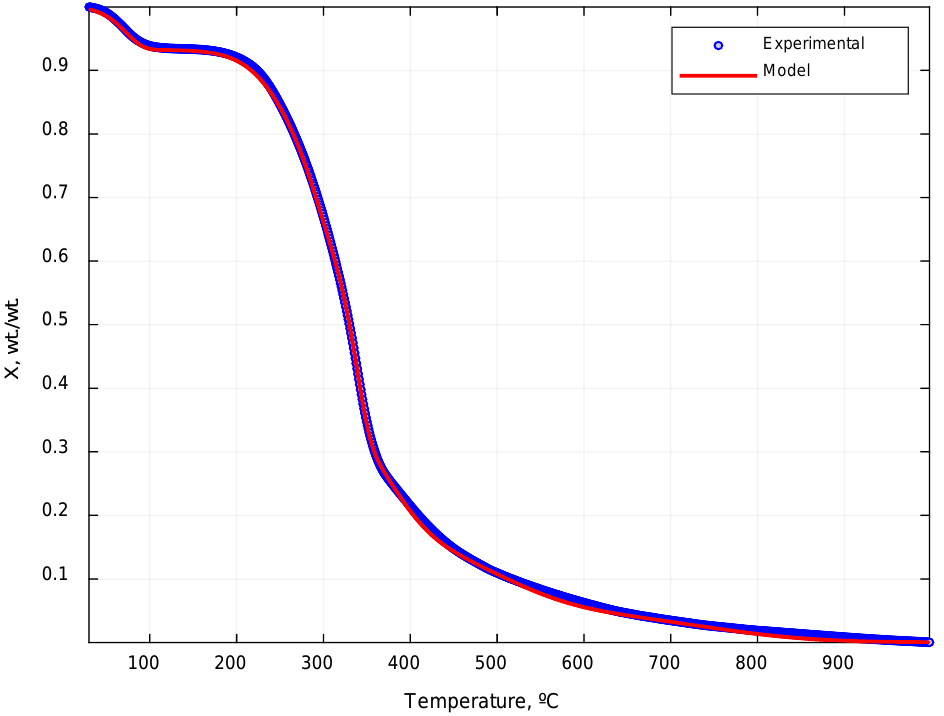
Figure 8. Model fitted to the experimental pine bark TG curve.